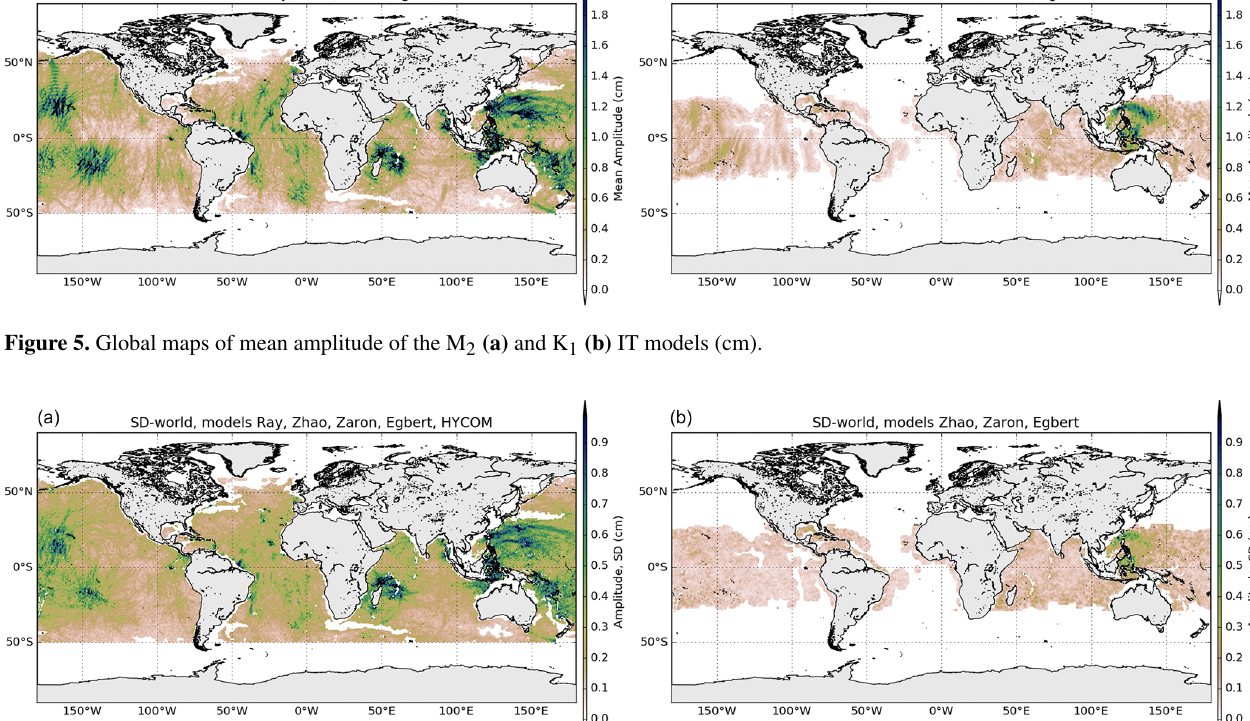
Figure 6. Global maps of standard deviation of the M 2 (a) and K 1 (b) IT models (cm).